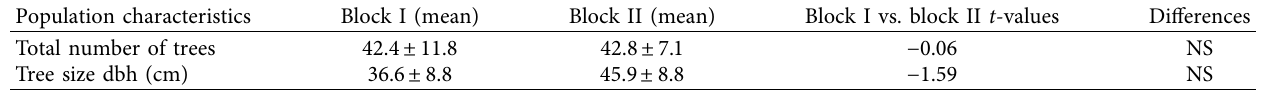
Table 1: T -test for population characteristics of P. falcatus individuals ≥ 5cm in the two blocks.